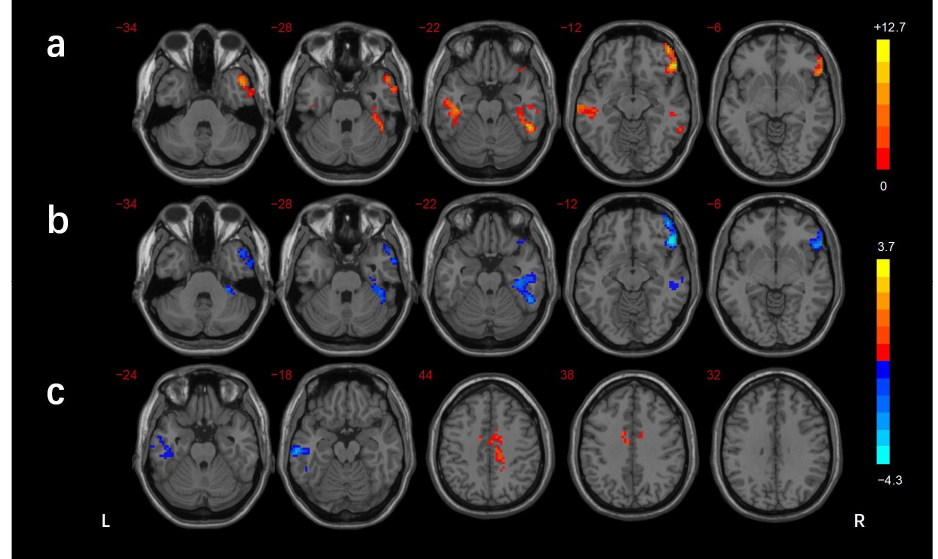
Figure 4. Comparison of short-range FCDs among groups (GRF corrected p < 0.005, cluster level p < 0.05). ( a ) Significant difference in short-range FCDs among three groups. ( b ) Significant difference in short-range FCDs between the DMCI and HC groups. ( c ) Significant difference in short-range FCDs between the DMCN and HC groups. The color scale denotes the t -value. L, left; R, right.